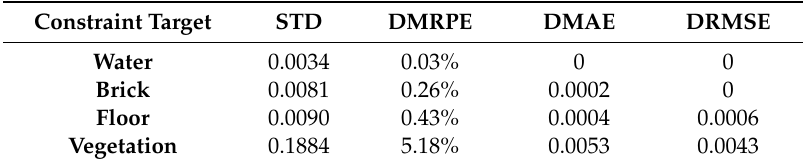
Table 8. The standard deviation and precision improve e ff